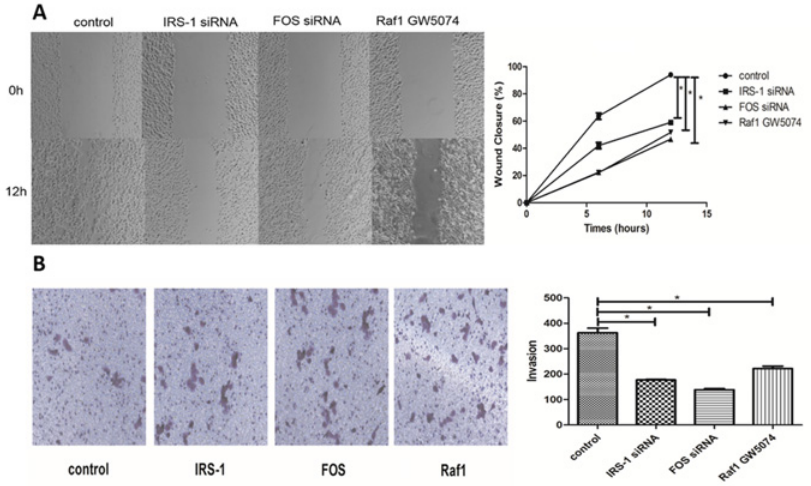
Fig 2. Differentially proteins play a major role in cell migration, and invasion of PC-1.0 Metastatic. (A) Effect of three proteins on the migration after using siRNA or antibody blocking in highly metastatic PC-1.0 cells. The cells were incubated for 24h. The percentage migration was calculated and graphed. * Compared with the PC-1.0, P -value < 0.01. (n = 3) (B) Quantification of transwell assay for treated group and control group. Cells were counted in triplicate wells and in three identical experiments, * Compared with the PC-1.0, P -value < 0.01. (n =